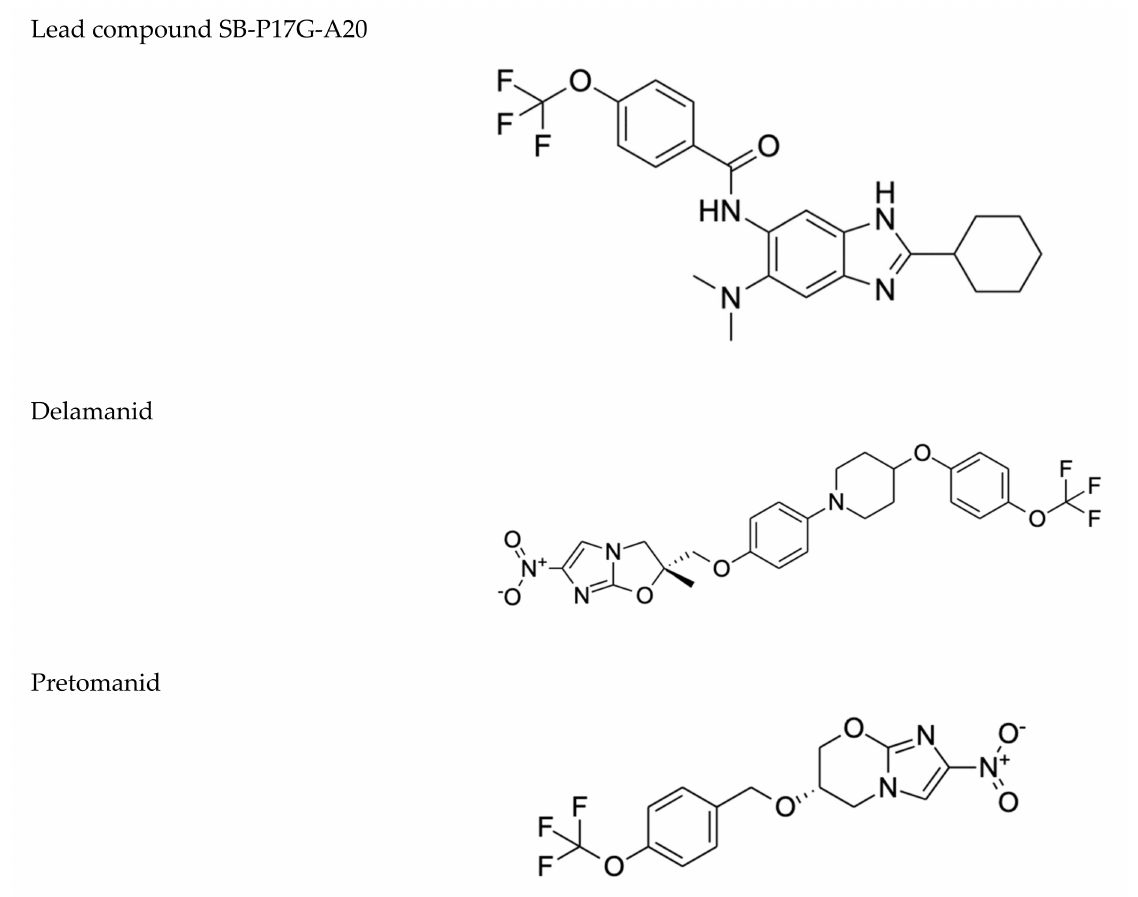
Figure 1. Benzimidazoles: a representative compound of this class of nitroimidazoles [89] along with delamanid and pretomanid, two drugs in clinical use against drug-resistant